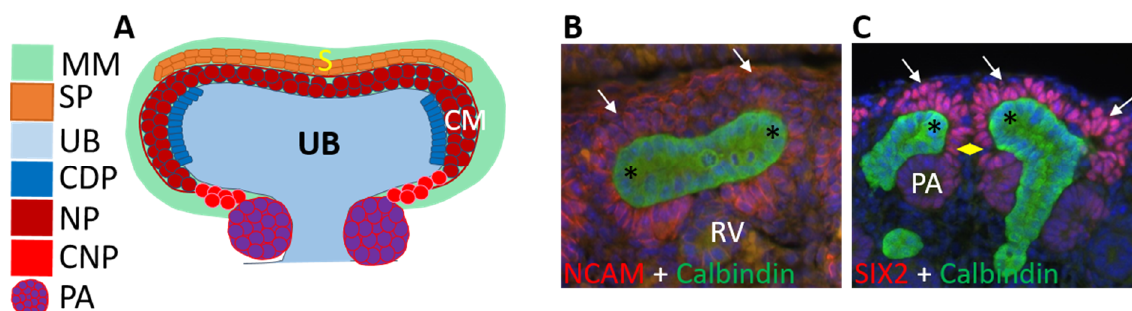
Figure 3. The illustration of embryonic kidney’s stem cell populations. ( A ) Schematic presentation of different kidney stem cells in their innate niches that are present during the mammalian renal organogenesis. Bifurcated ureteric bud (UB, light blue) has two tips that host collecting duct progenitors (CDP, dark blue rectangles). Immediately adjacent to the epithelial ureteric bud are nephron progenitors (NP, dark red circles), which are located in the cap mesenchyme (CM) compartment of metanephric mesenchyme (MM, green). Nephron progenitors’ stemness depends on their localization in their relationship with ureteric bud tips. Nephron progenitors that are in the armpits of the ureteric bud represent more differentiation-committed nephron progenitors (CNP, red circles), which can shuffle back and forth of the nephron progenitors in the cap mesenchyme compartment (NP, dark red circles). Fully committed nephron progenitors end up to pretubular aggregates (PA, purple balls), which are the first precursor forms of differentiating nephrons. The most cortical metanephric mesenchymal (MM, green) cells are stromal (S) cells, which also contain the stromal progenitors (SP, yellow-brownish rectangles) surrounding the outermost layer of nephron progenitors. ( B ) Embryonic kidney at day 14.5